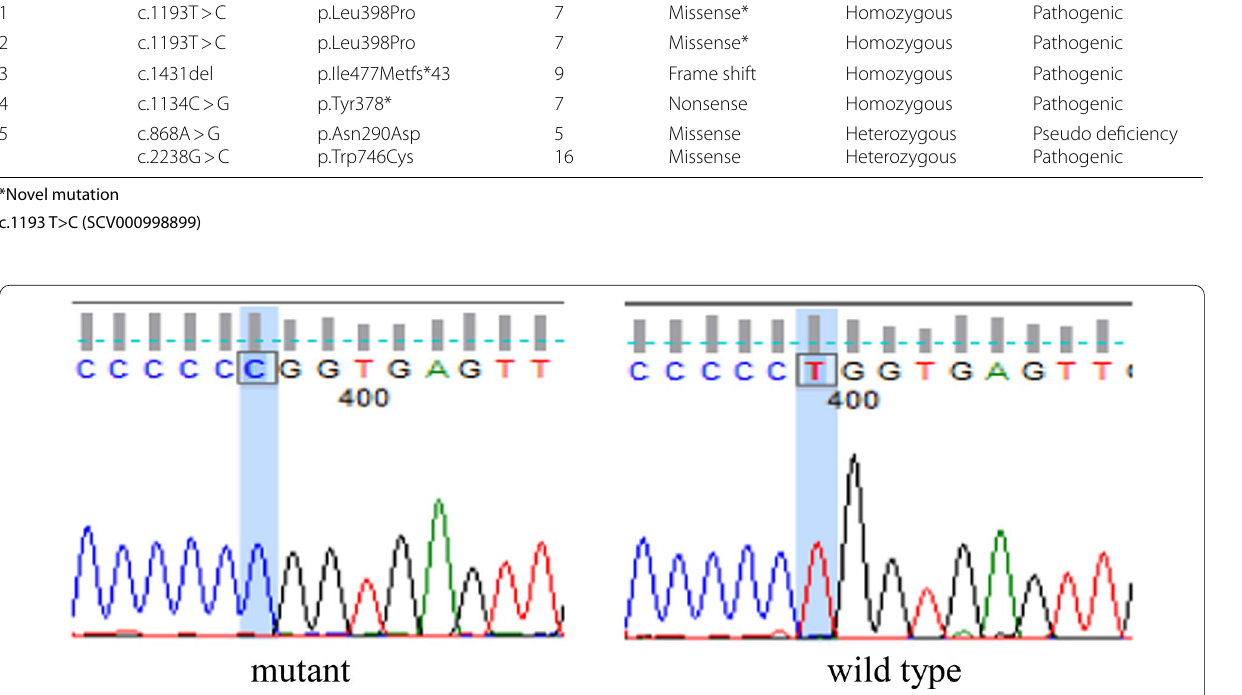
Fig. 1 Sequencing electropherogram of the novel missense mutation. ClinVar accession is written between